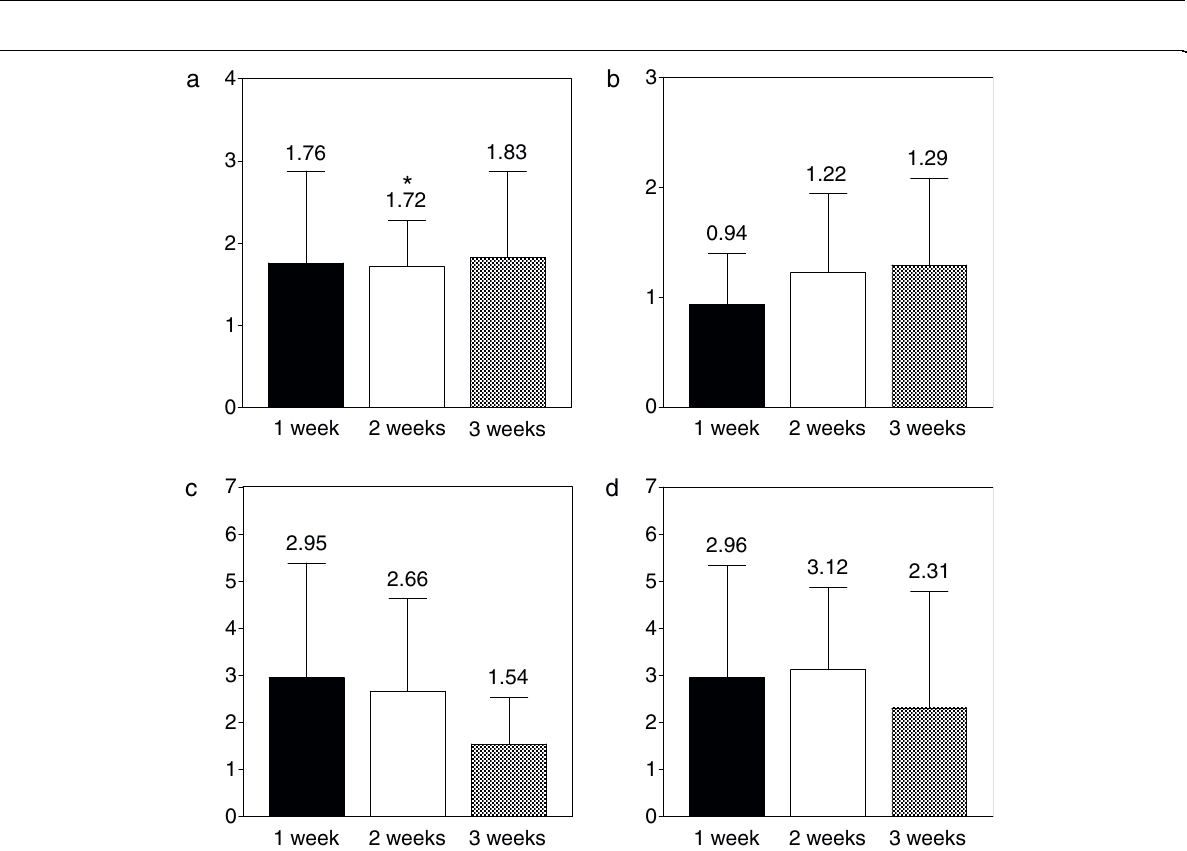
Figure 4 Real-time PCR analysis of matrix-specific genes . Real time PCR analysis of col-II (a), aggrecan (b), col-I (c) and interleukin-1 b (d) gene expression. Data are given as relative gene expression of stimulated samples in relation to gene expression of untreated samples of the same patients, which were set as 1. B-actin gene expression was included as internal standard. Given are mean +/- SD. N = 10. P =